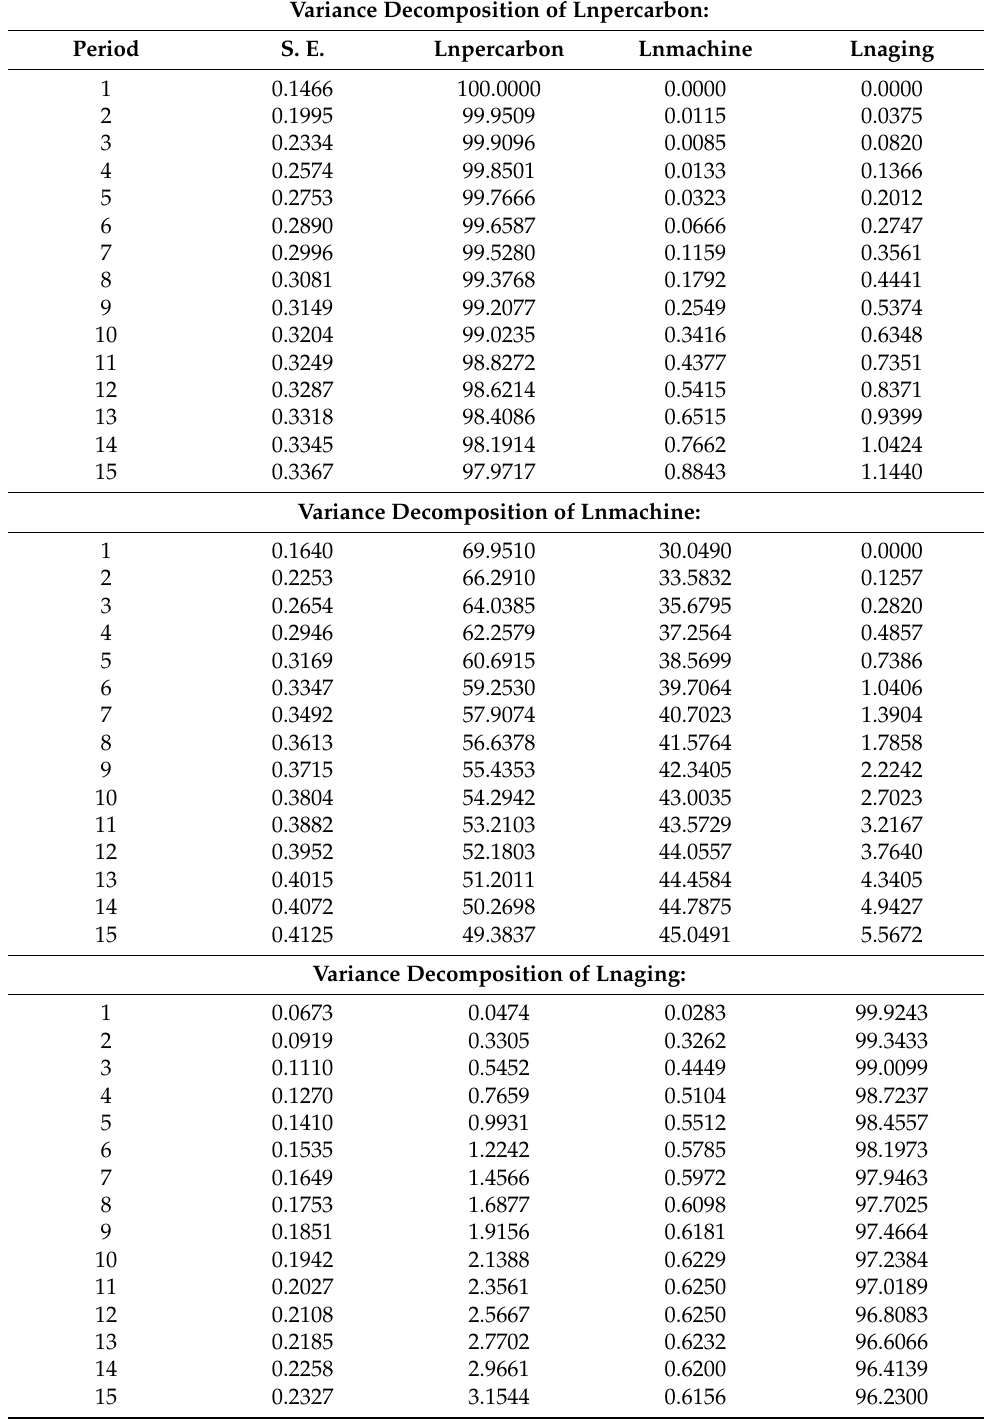
Table 10. The impulse response and variance decomposition